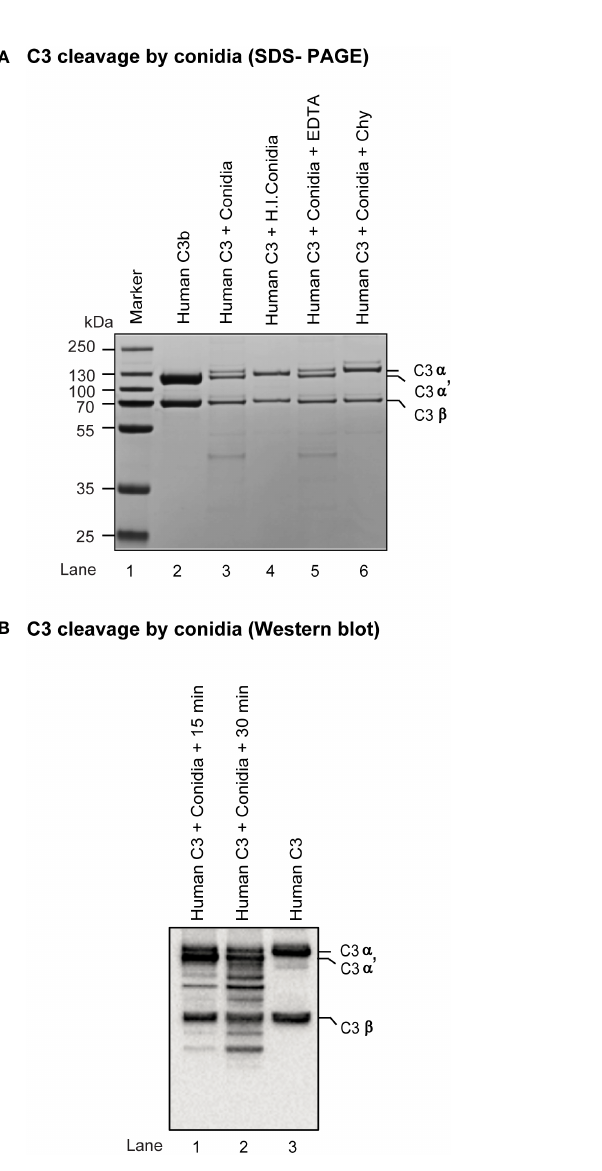
FIGURE 3 Cleavage of complement protein C3 by A fumigatus conidia. (A) Human C3 (3 µg) was incubated for 30 min at 37°C with 1x10 7 conidia in a total reaction volume of 50 µl in Tris-buffer pH 7.4. Following incubation, the reaction mix was centrifuged at 10,000 rpm for 5 min. Supernatants were loaded on a 7.5% SDS-PAGE, and the cleaved fragments of C3 were visualized by staining the gel with Coomassie blue. Heat inactivated conidia: heat-inactivated by incubating it at 95°C for 5 min. Cleavage of C3 by A fumigatus conidia was performed in the presence of inhibitors: EDTA, (10 mM); Chy, Chymostatin (100 µg/ml). Conidia effectively cleaved C3, which could be inhibited by Chymostatin, but not by EDTA. The PAGE pro fi le shown is a representative of three independent experiments. (B) C3 cleavage capacity of conidia was also examined by Western blot by incubating human C3 (3 µg) with 1x10 7 conidia for 15-30 min at 37°C, collecting and subjecting the supernatant of the reaction mixture to SDS-PAGE (gradient gel, 4-12%), blotting separated protein bands on to nitrocellulose membrane, probing the membrane with anti-C3 antibody (Merci Millipore) and revealing the bands using ECL detection kit (Pierce); the experiment was repeated